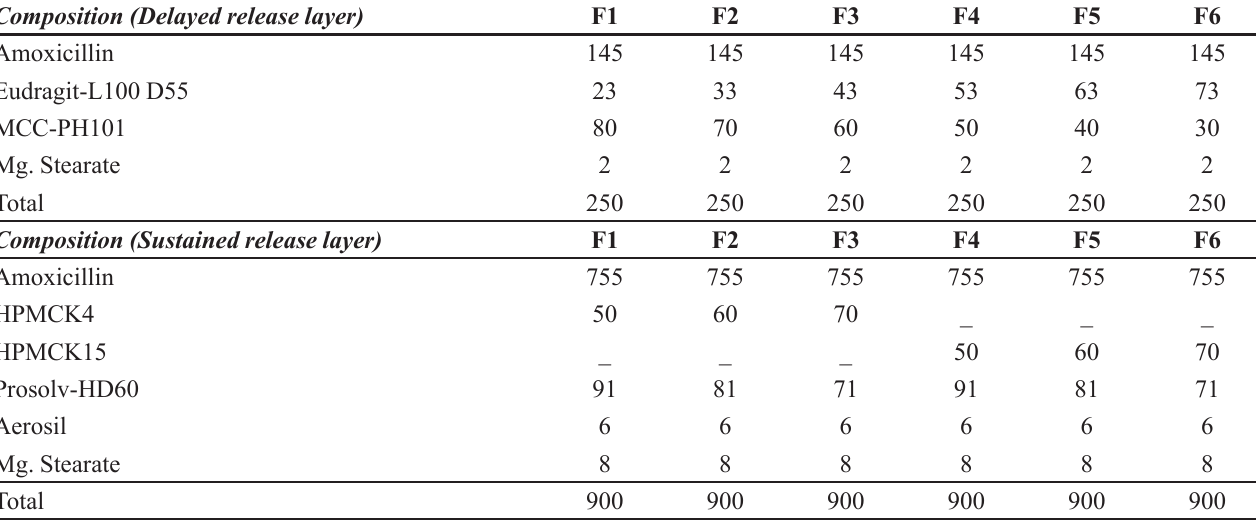
TABLE I - Composition of time-dependent bilayer tablet of amoxicillin trihydrate Composition (Delayed release